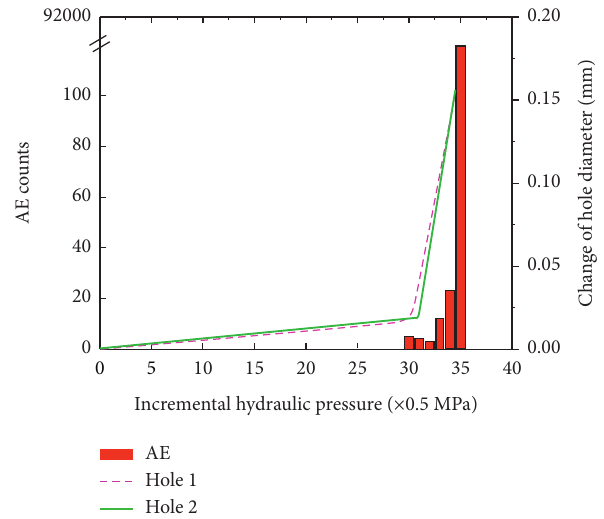
Figure 5: Relationship between hydraulic pressure increment and AE and radius increment for the double-wellbore